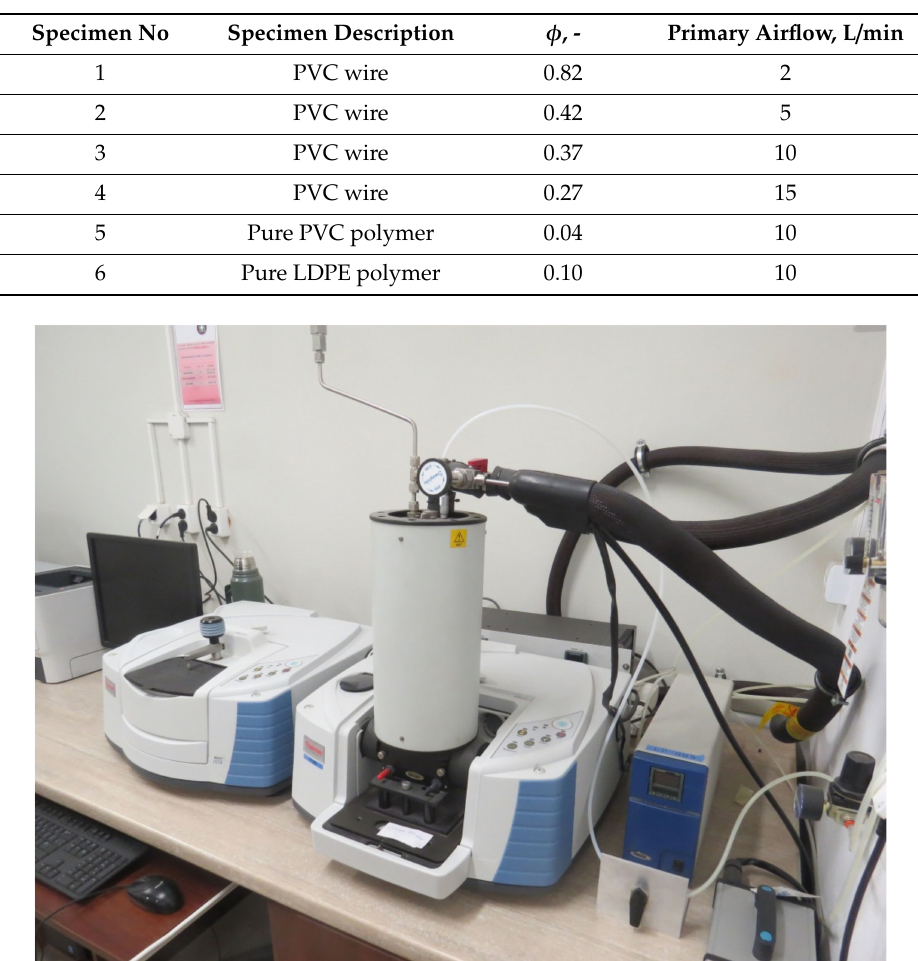
Figure 3. FTIR spectrometer at the accredited ITB Fire Laboratory in Pionki,